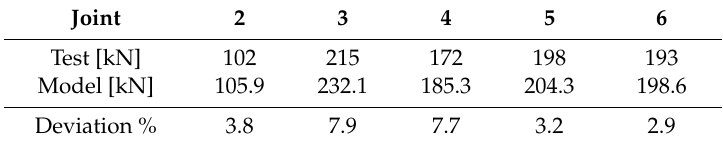
Table 2. Maximum load from tests and simulation.